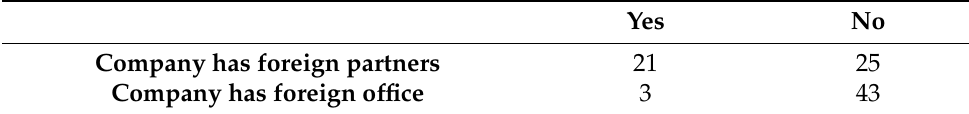
Table 3. International business interest, business contacts.